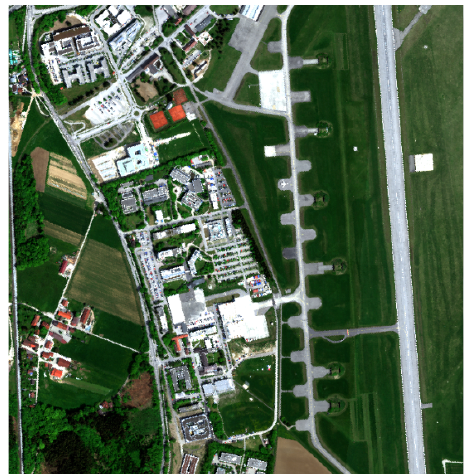
Figure 8. True colour composition of HySpex image acquired over DLR premises at Oberpfaffenhofen, Germany